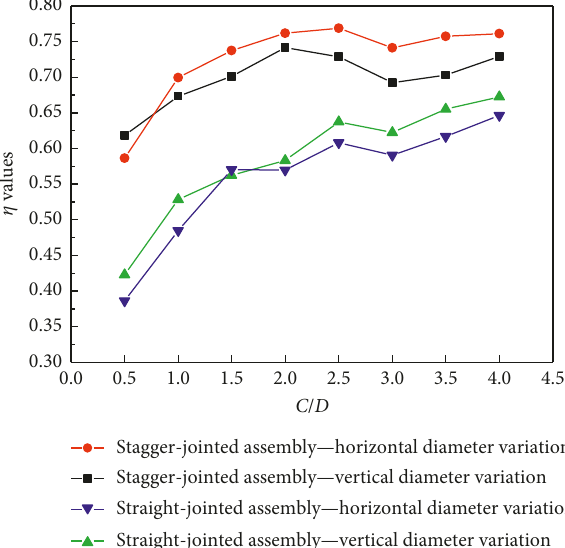
Figure 15: Relationship between the effective ratios of the transverse bending rigidity and loads under the realistic loading